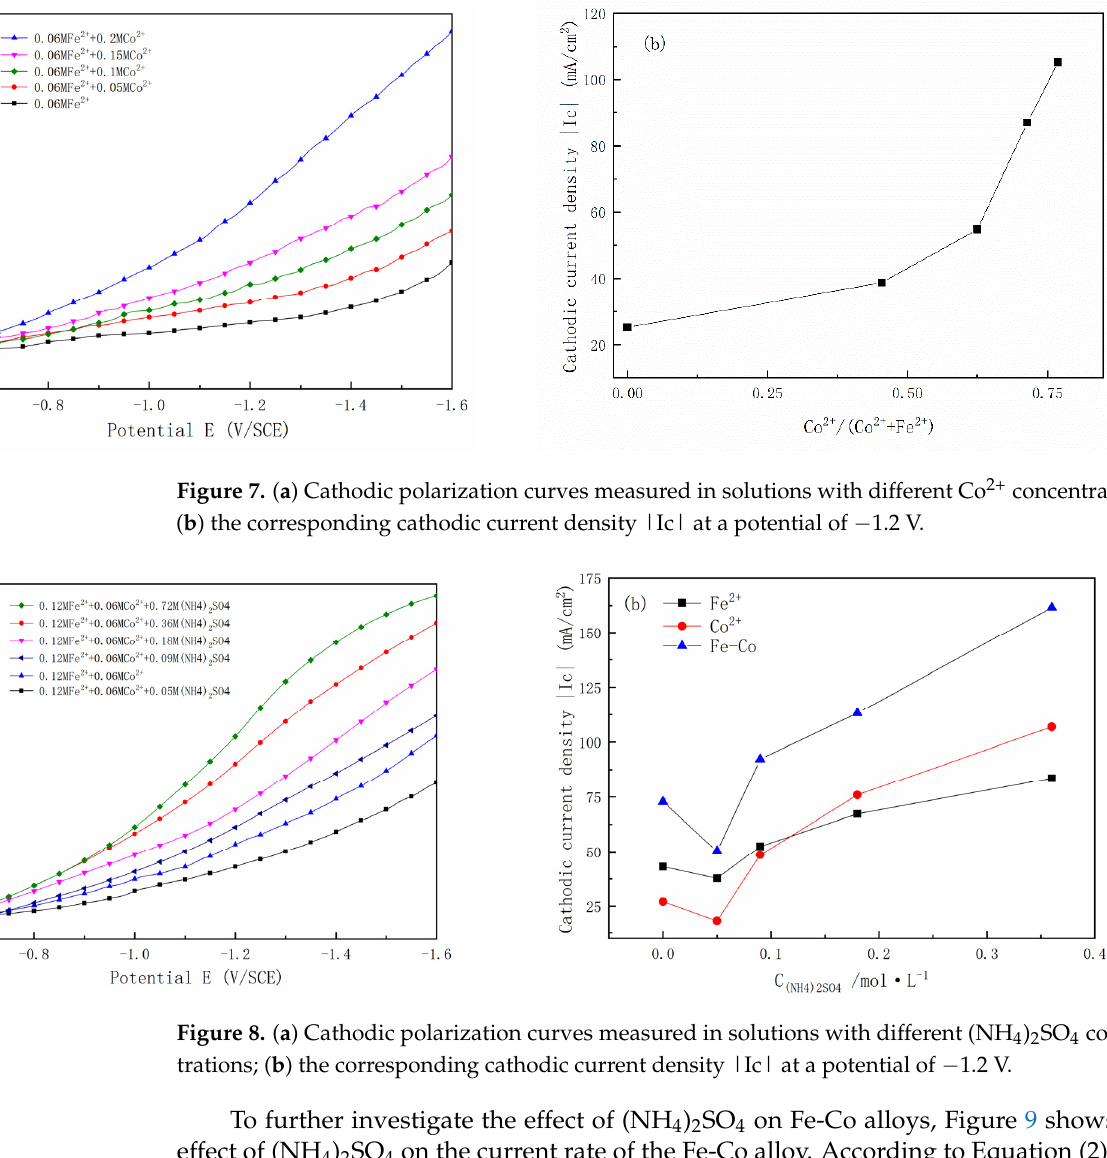
Figure 7. ( a ) Cathodic polarization curves measured in solutions with di ff erent Co 2+ concentrations; ( b ) the corresponding cathodic current density |Ic| at a potential of − 1.2 V.